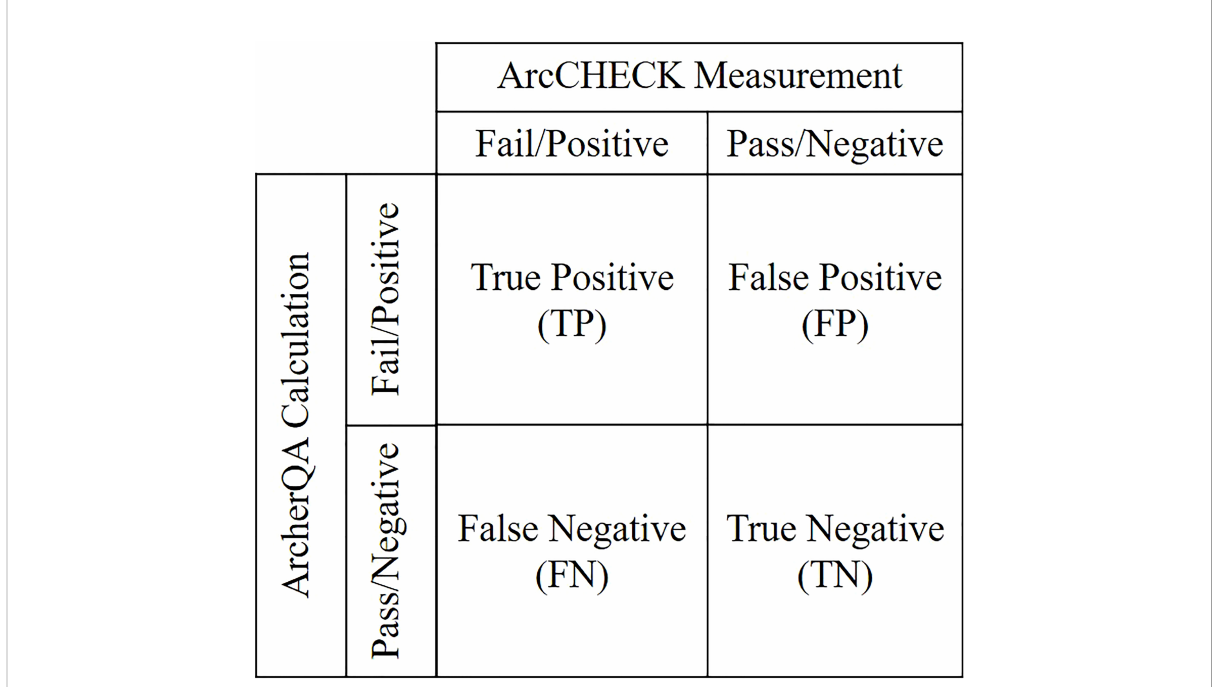
FIGURE 2 Four categories of plans charactered with ArcCHECK measurement and ArcherQA